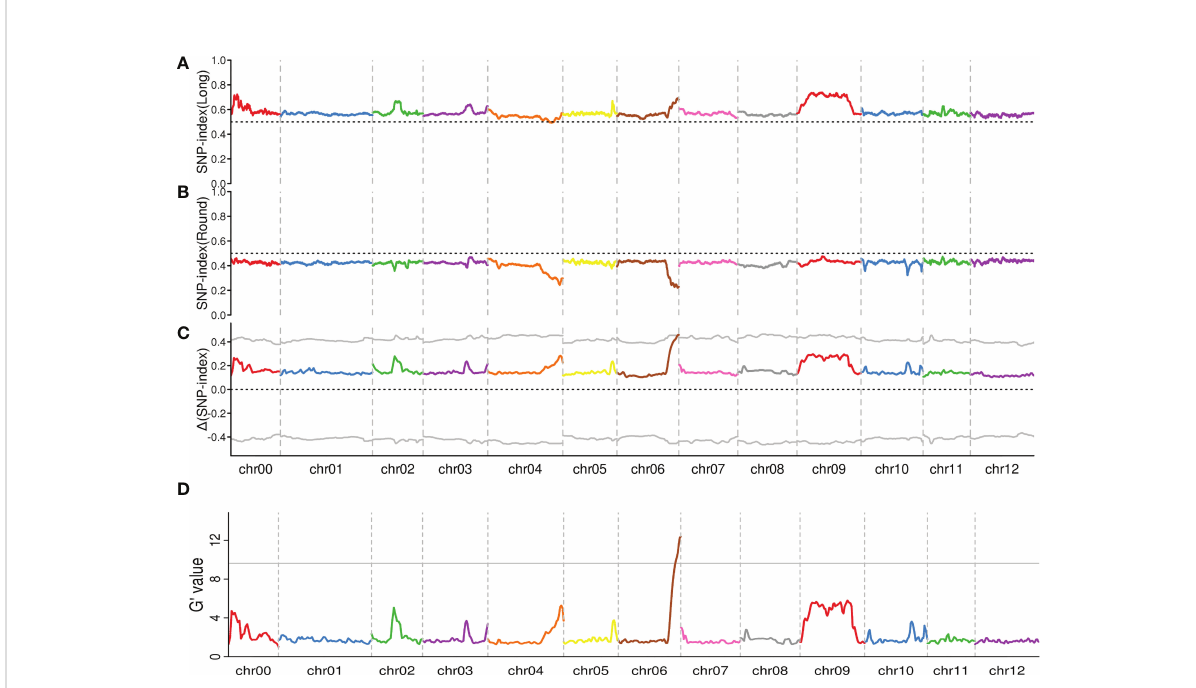
FIGURE 3 Identi fi cation of a genomic region corresponding to tuber shape by calculating the SNP-index and the G ’ value. The x-axis represents the position of 12 chromosomes of the potato genome and the y-axis corresponds to the average SNP-index or G ’ within a 2 Mb interval. (A) The SNP-index graph of the Long-pool. (B) The SNP-index of the Round-pool. (C) The D (SNP-index) graph, the grey dotted line represents that D (SNP-index) plot with 95% statistical two-sided con fi dence intervals under the null hypothesis of no QTL. (D) G ’ graph, the grey line represents the p-values